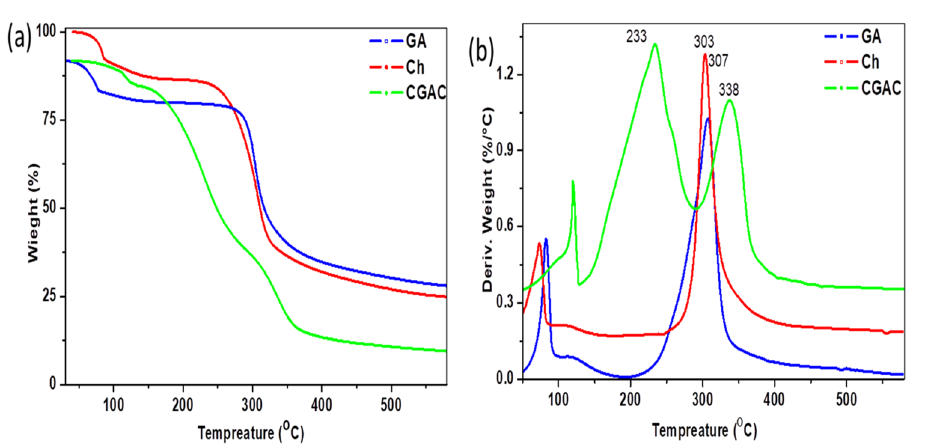
Figure 7. ( a ) TGA and ( b ) DTGA for CGAC nanopowder and its parent